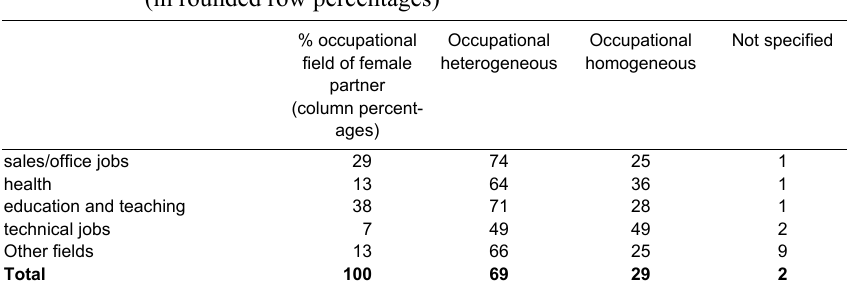
Table A3: Presence and age of underage children* and age of the woman in academic couples, 2004 (in rounded column percentages) Total 30-39 yrs old 40-49 yrs old No children under 18 32 35 30 Under 3 yrs 21 100